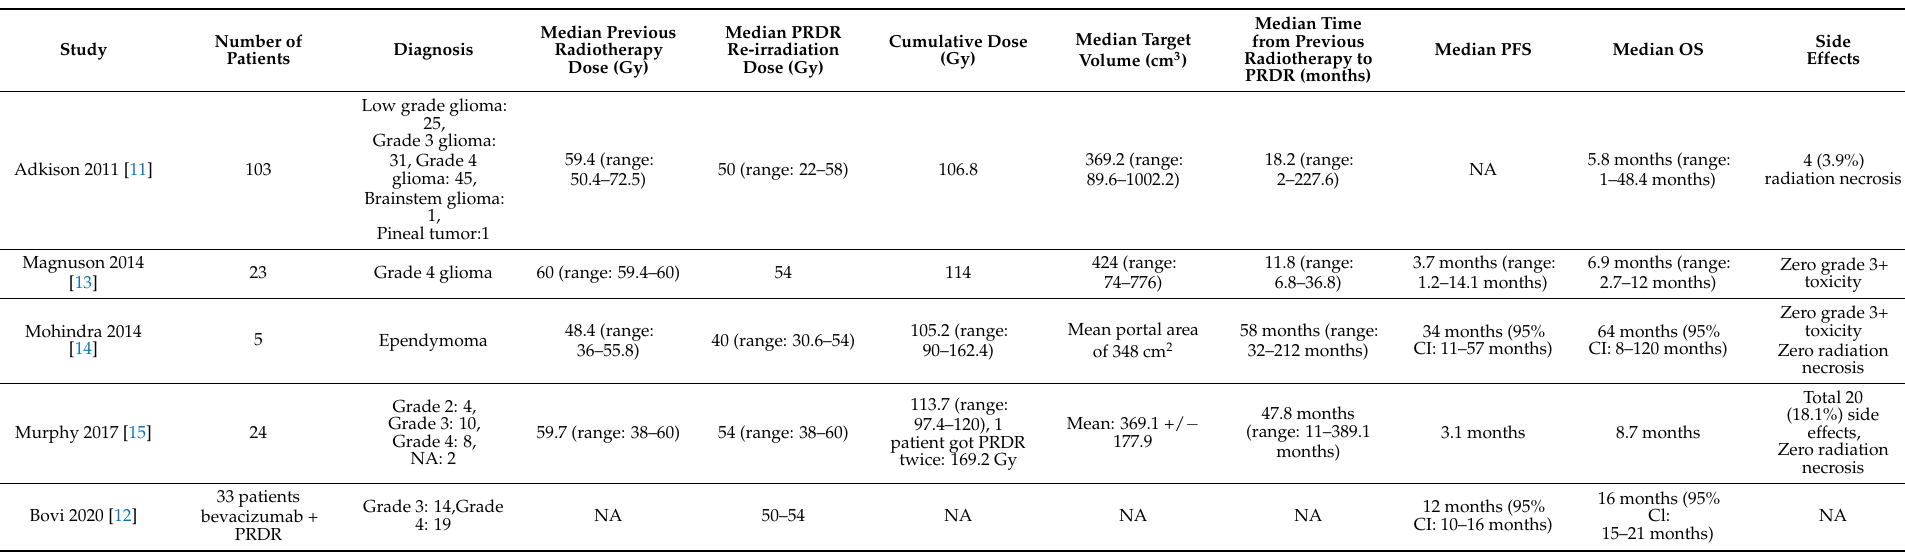
Table 4. Summary of the outcomes of published studies of